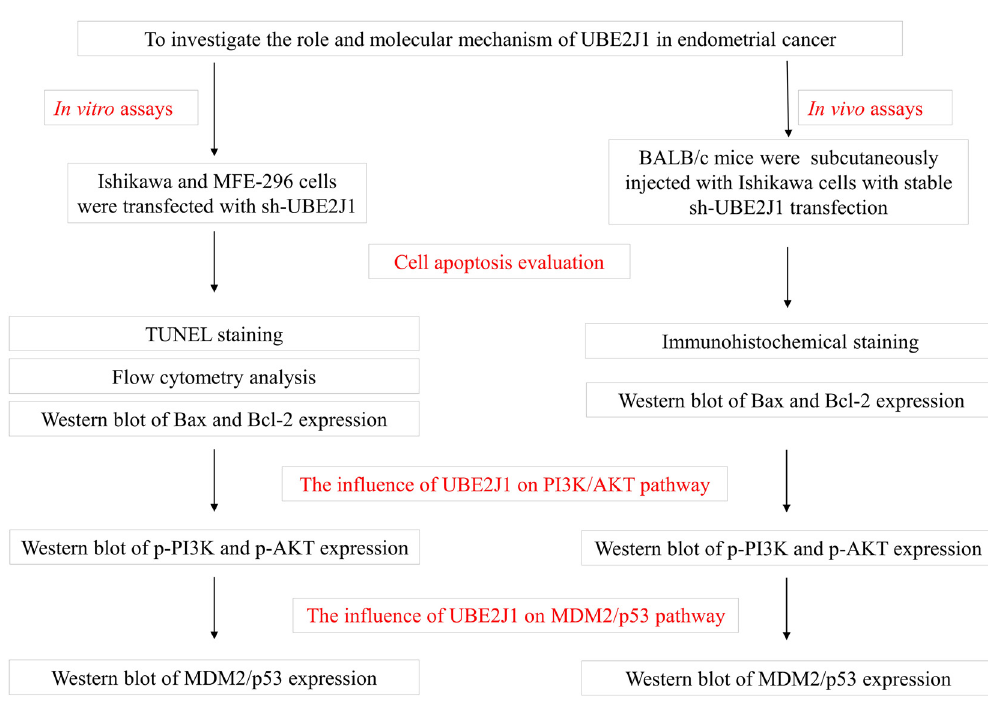
assay.Additional fi le 1 The fl ow chart of the main steps in our Table A1: The detailed statistics for each